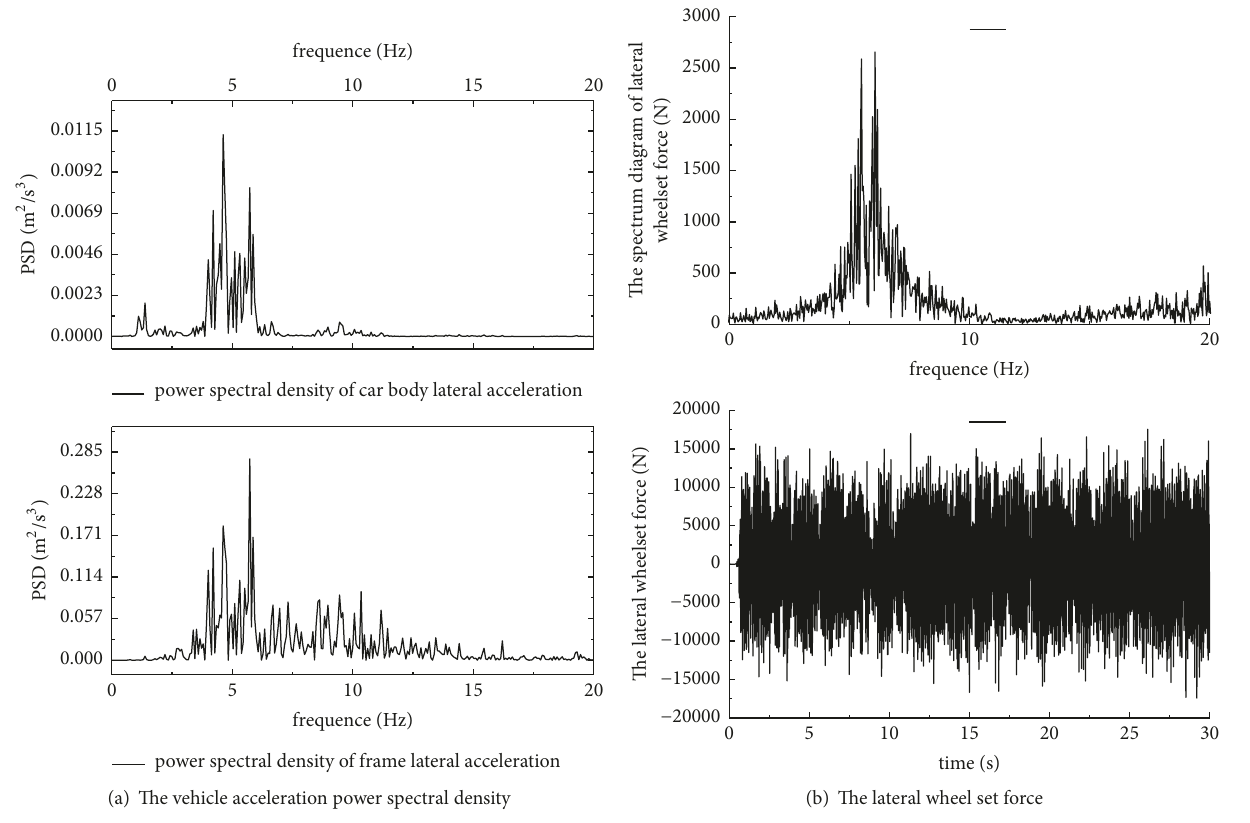
Figure 17: The vehicle acceleration power spectral density and the lateral wheel set